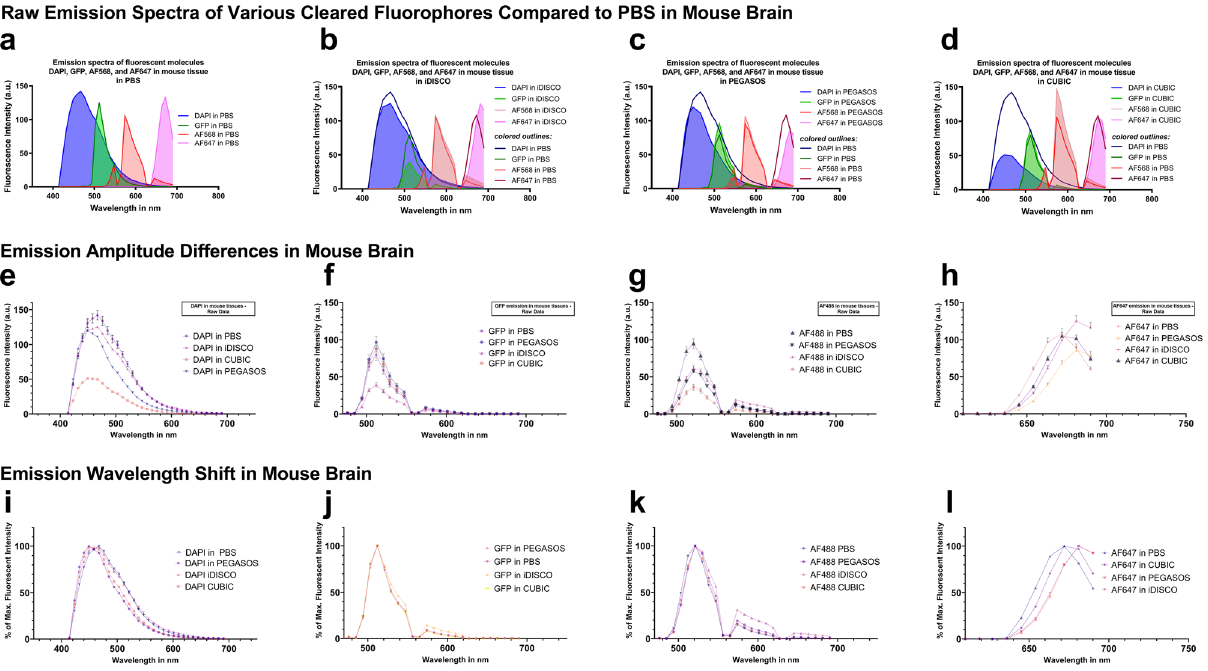
Figure 4. iDISCO, CUBIC, and PEGASOS clearing alter the fluorescent emission spectra of fluorophores and fluorescent dyes in mouse brain tissues. Confocal microscopy-based emission spectra of Alexa Fluorophores 488, 568, 647, eGFP, and DAPI in PBS ( a ) vary from those in iDISCO ( b ) , PEGASOS ( c ) , and CUBIC ( d ). Colored outlines in b-d represent emission profiles of PBS shown in a) to facilitate visual comparison. The line graphs ( e–h ) represent the individual emission signals of cleared tissues shown in ( a ) through ( d ) with Alexa Fluorophore 488 in addition: Raw emission data visualize the differences in the amplitude between measurements in PBS and cleared tissues ( e – h ). Emission data normalized to their peak intensity highlight the shift of the emission peaks to altered wavelengths ( i – l ). DAPI was excited at 405 nm, eGFP and Alexa Fluor 488 at 488 nm, and Alexa Fluor 647 at 633 nm . Error bars indicate standard error of the mean and are at times too small to be visible. The reduction of fluorescence emission around 560 nm stems from the beam splitter in the light path ( f – h and j – l ; e , i used a different beam splitter without this gap). Spectra are shown as means measured in n = 25 regions of interest per fluorophore across 5 separate biological